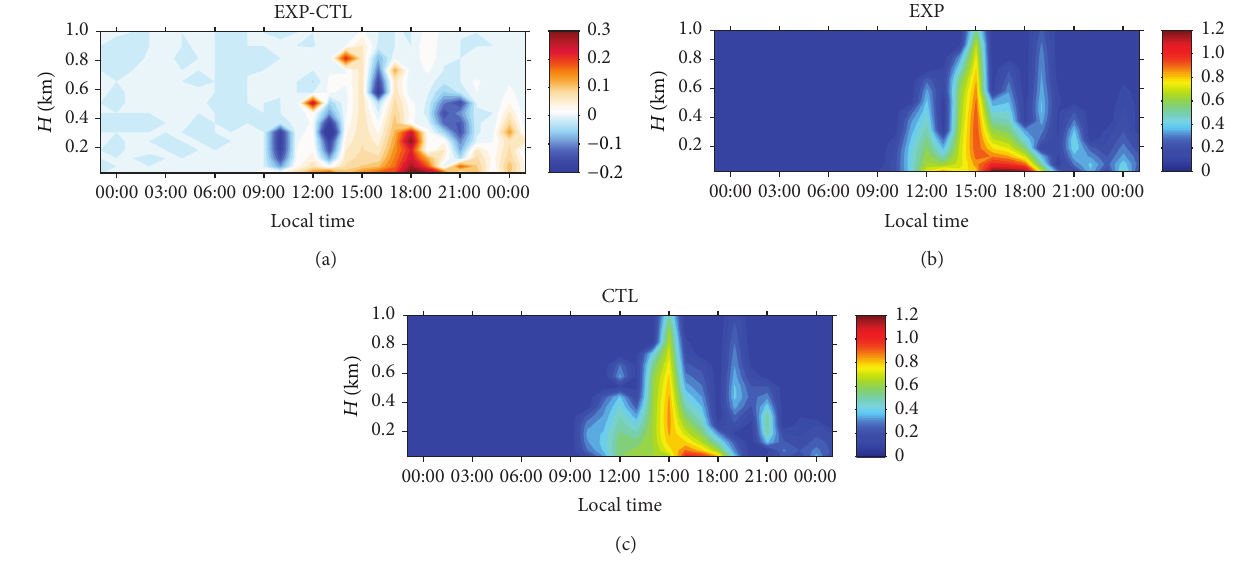
Figure 9: Diurnal variation of turbulent kinetic energy ( m 2 s −2 ) simulated by the CTL run and the EXP run at the B325 Tower and their differences during 0000 LST 28 February to 0000 LST 1 March